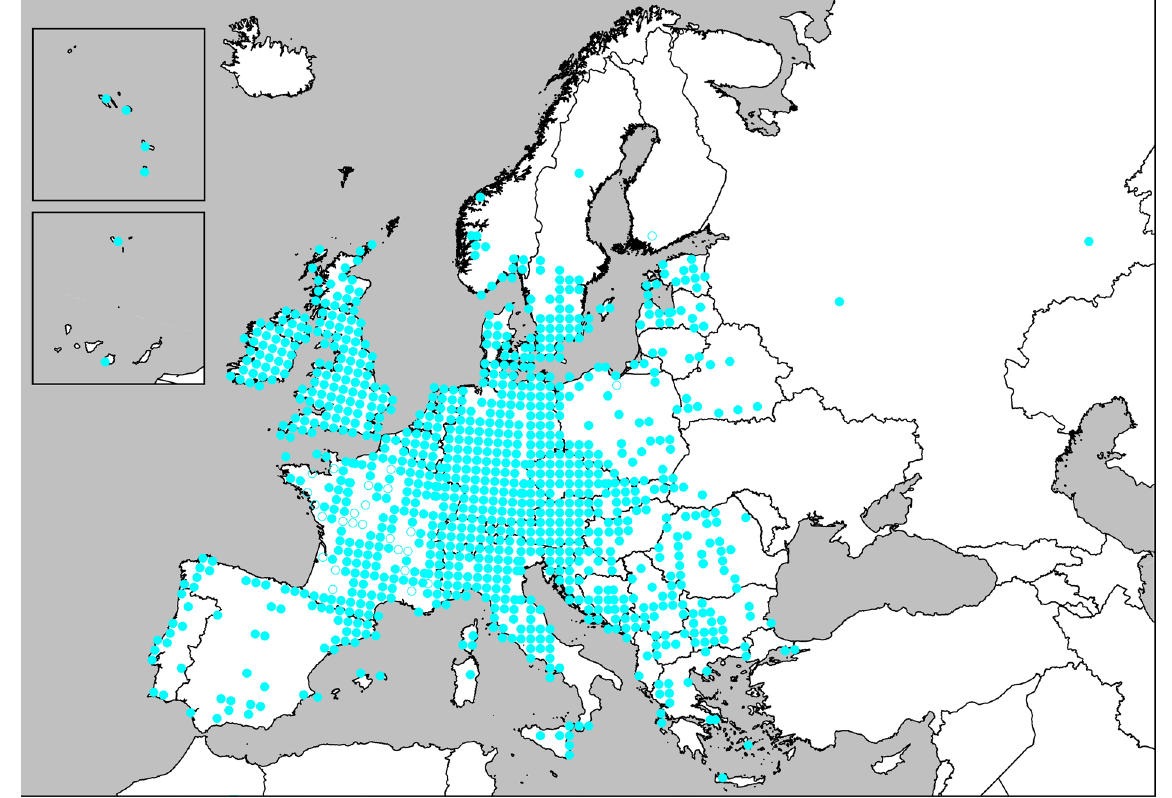
Fig. 6. Map showing all the 50 km squares which provided records in